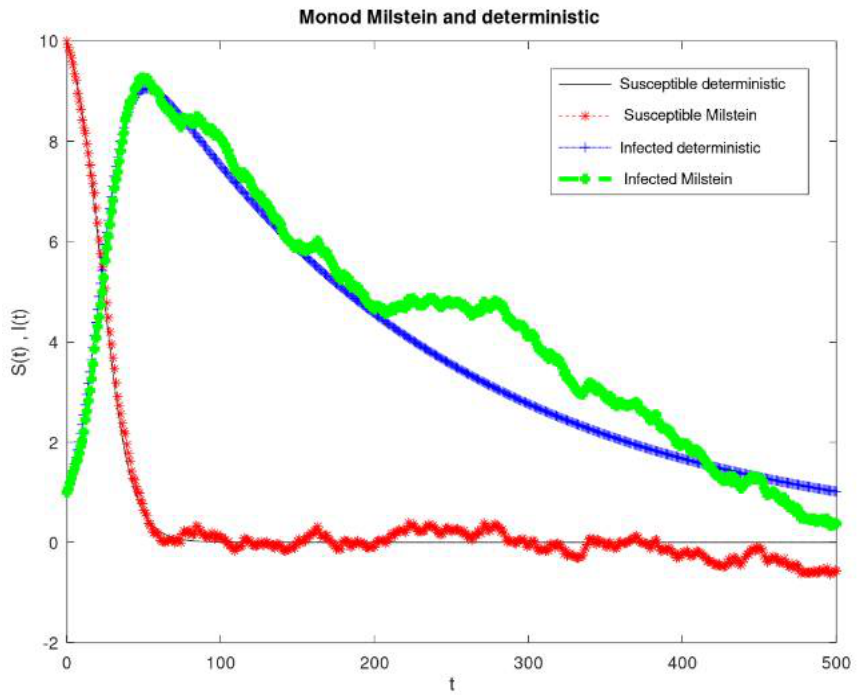
Figure 1. Plot of the dynamic behaviors of the susceptible and infected populations under the intervals (cid:101) β = 0.01 and (cid:101) γ = 0.01.